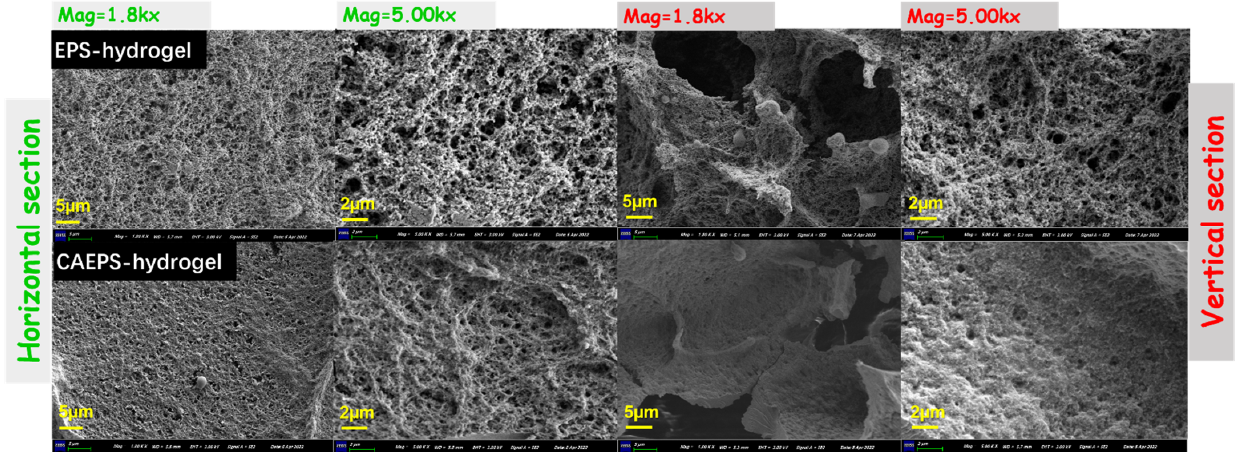
Figure 5. SEM image of EPS- and CAEPS-hydrogel at 1.8K× Magnification, scale bar: 5 µm; 5.00K× Magnification, scale bar: 2 µm, respectively. Note: The samples were subjected to vacuum freeze- drying to remove moisture and tested at room temperature.